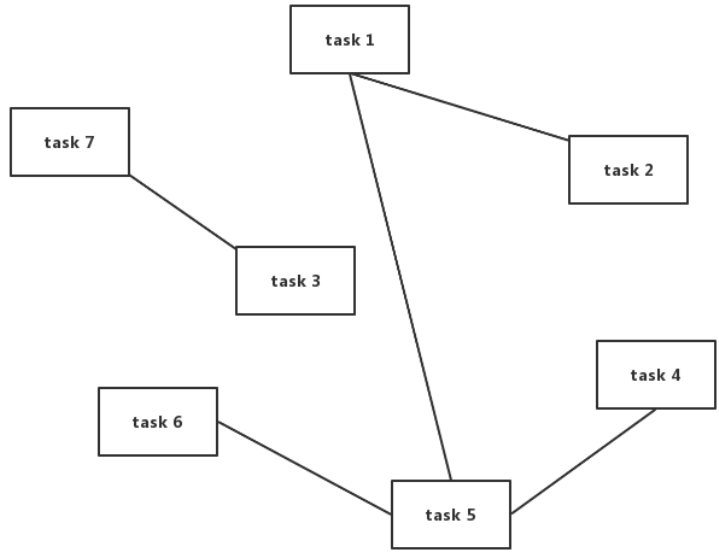
Figure 2. Example: privacy conflict graph with seven